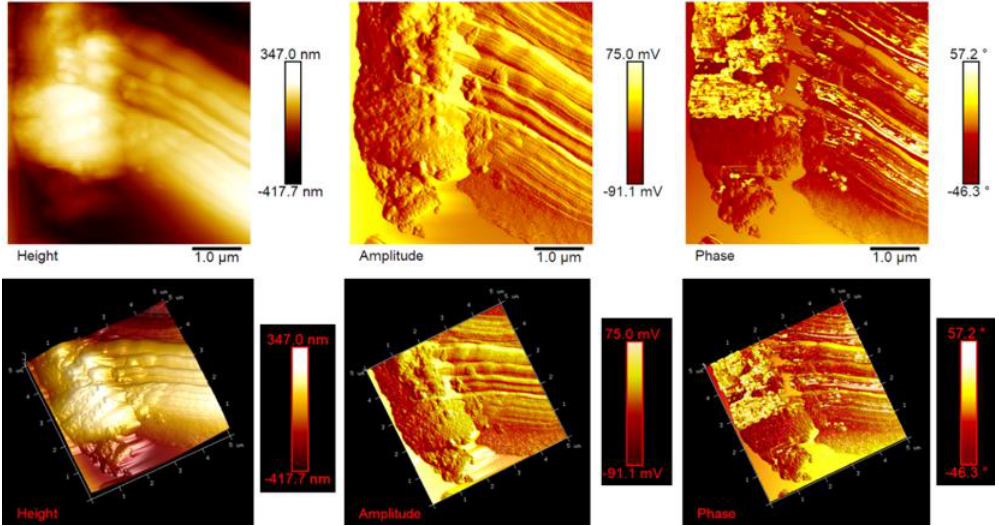
Figure 14. Tapping mode AFM micrographs of the fracture surface of the TBD + 1%CNFs heat-treated sample (see on the top) and the corresponding 3D profiles (see on the bottom).